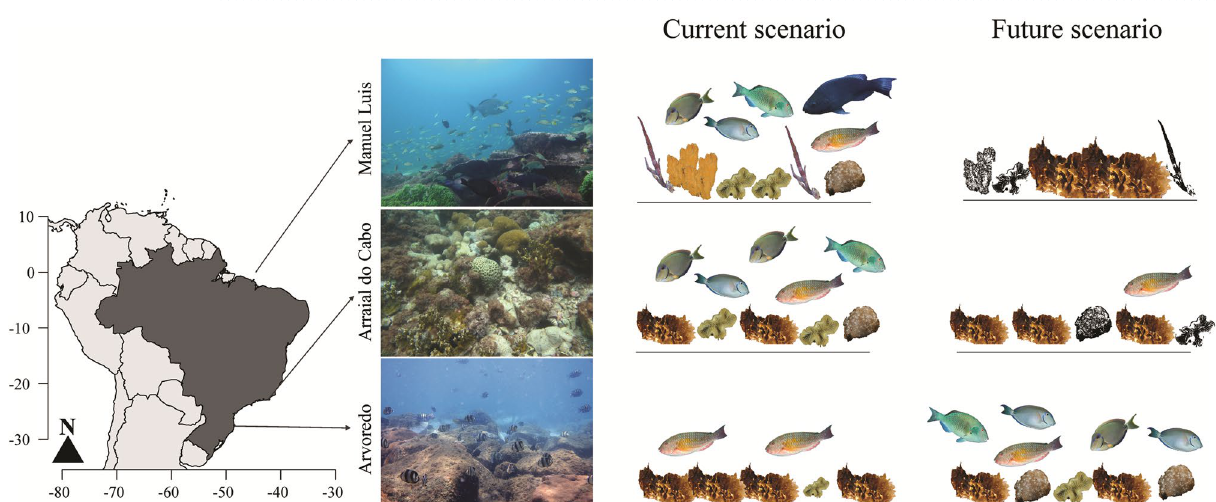
Figure 6. Climate-change induced tropicalization of subtropical and temperate reefs. Schematic representation of the projected changes in reef ecosystems of the western south Atlantic (first column) caused by tropicalization. The second and third columns depict the present-day higher biomass of herbivore reef fish in the tropics 56 and higher macroalgae and turf algae biomass in the subtropic and temperate sites 57 . The future climate change scenario is depicted in the fourth column with an increase of algal cover in tropical reefs as a response to greater mortality of grazers and reduced grazing pressure. Subtropical to temperate reefs will display higher grazer fish biomass and lower dominance of macroalgae. Created with Adobe Illustrator-2020 (https:// www. adobe.